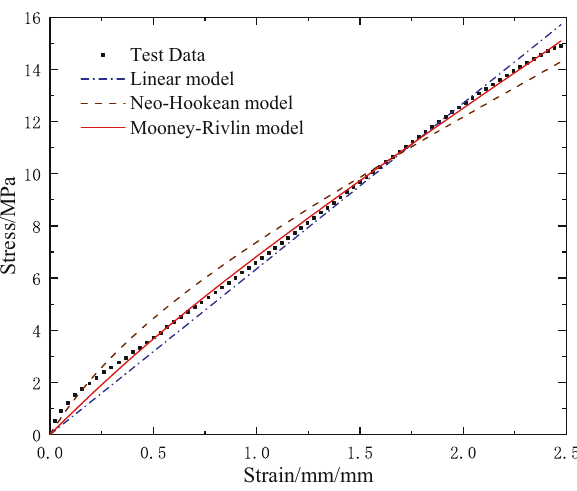
Figure 7: Test data fi tting analysis for the stave rubber